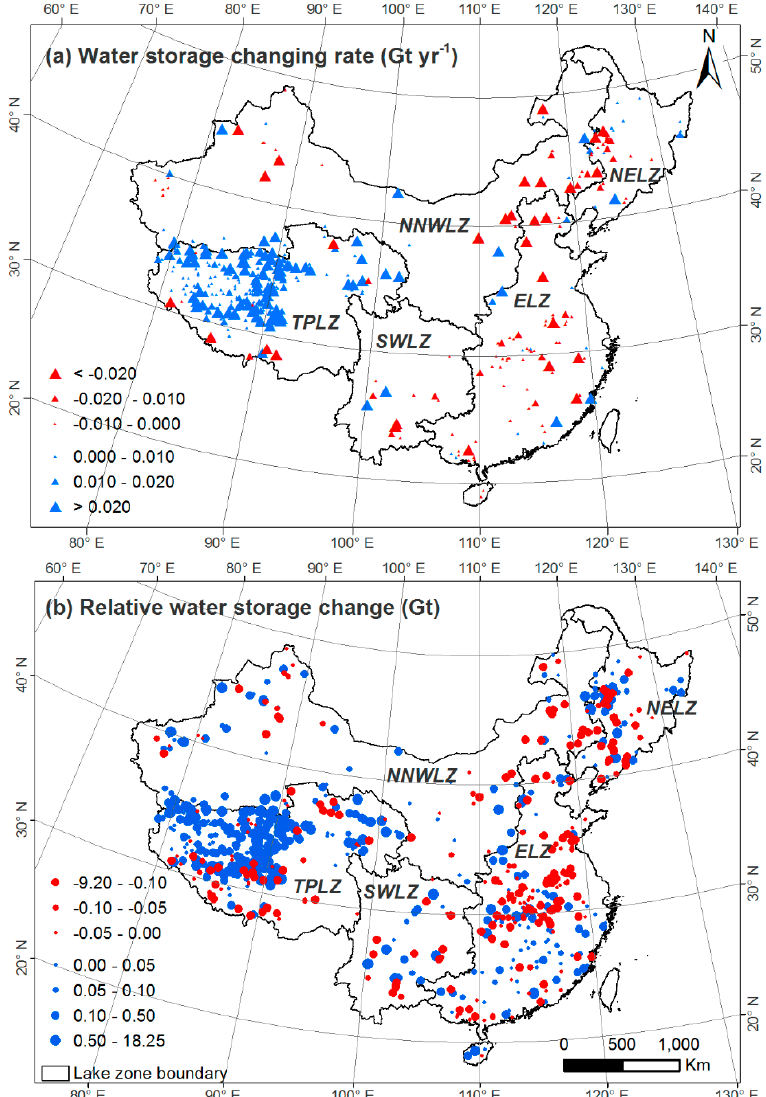
Figure 8. Spatial distribution of water storage change ( ∆V ) in lakes and reservoirs across China, 1984–2015. ( a ) The temporal changing rate of ∆V for the two monotonically changing types (N = 412). ( b ) The total amount of ∆V for all the 760 lakes and reservoirs relative to the first year of analysis.